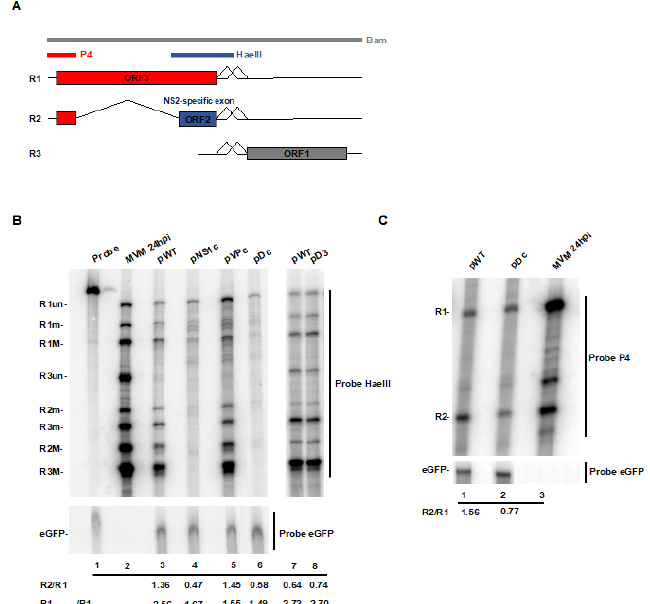
Figure 3. CTCF-binding site mutants exhibit a decrease in levels of spliced to un-spliced R1, and levels of R2 relative to R1. ( A ) Genetic map of MVM showing the three major transcript classes (R1, R2, and R3), the open reading frames that encode the two non-structural (ORF2 and ORF3) and the capsid (ORF1) proteins, and the relative positions of the small and large introns. Approximate locations of the RNase protection viral probes (Bam, P4 and HaeIII) are also indicated. ( B ) Human NB324K cells were infected with MVMp at an MOI of 10 or co-transfected with the indicated plasmids and eGFP. Infected cells were harvested at 24 hpi while transfected cells were harvested at 48 hpt and total RNA was isolated using TRIzol reagent. Samples were processed for RNase protection assay (RPA) using a HaeIII (that detects all viral transcripts) or an eGFP probe, as described in Materials and Methods. The protected bands representing all nine viral mRNA species are indicated to the left. The ratios of total R2 to total R1, and spliced to unspliced R1 are indicated at the bottom of the panel. Ratios represent an average of two independent experiments. ( C ) RPA of total RNA extracted from NB324K cells 24 h post infection or 48 h post transfection with the indicated plasmids using the P4 viral probe, detecting specifically the P4-generated transcripts, or the eGFP probe. The identities of the protected bands are shown on the left. The ratio of R2 to R1 is indicated at the bottom of the panel. Ratios represent an average of two independent experiments .